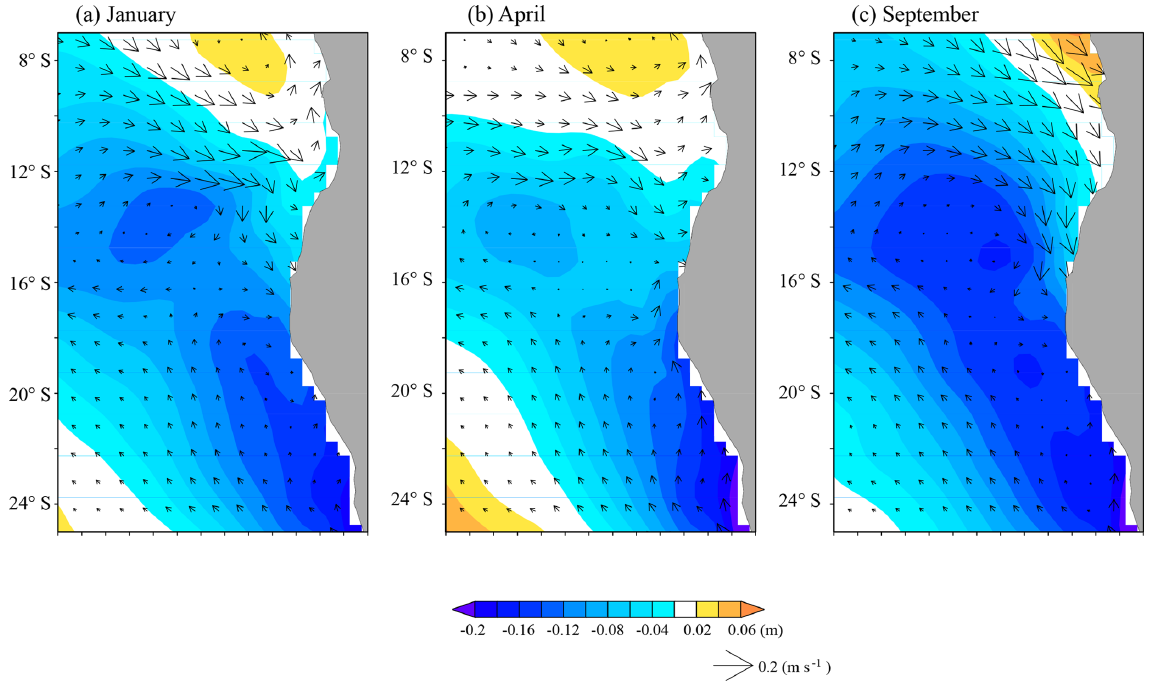
Figure 7. Monthly mean SSH (color) and geostrophic current (arrows) for (a) January, (b) April, and (c) September.